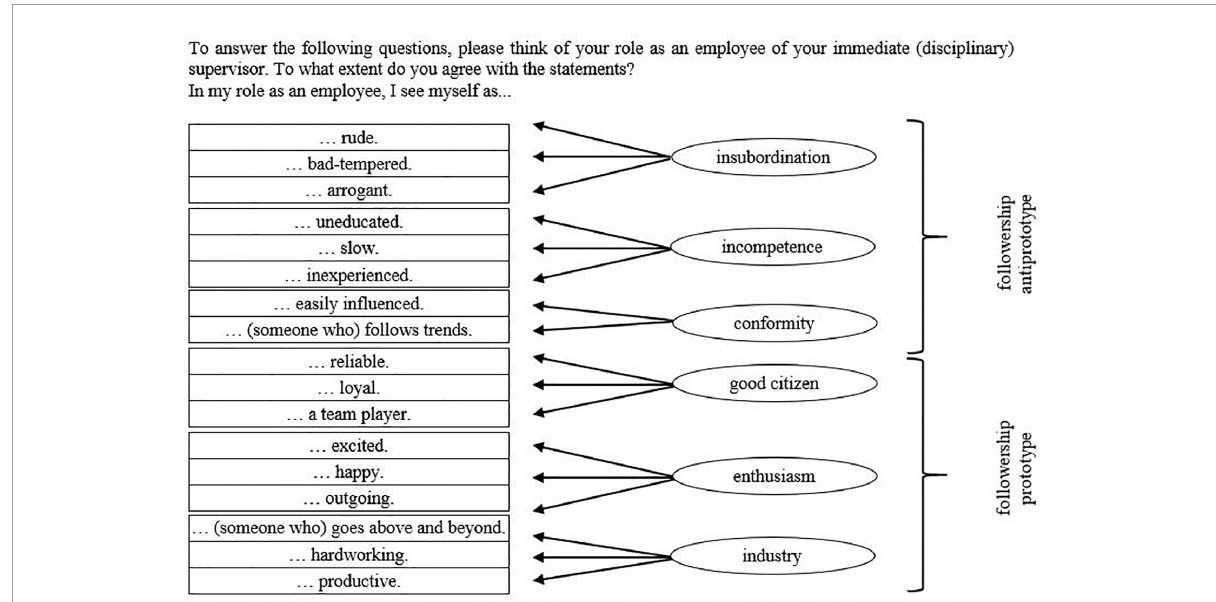
FIGURE1 Sy (2010) Followership Prototype and Followership Anti-Prototype and their query in the study. “Soft spoken,” the third item of Conformity is not depicted, as it was not